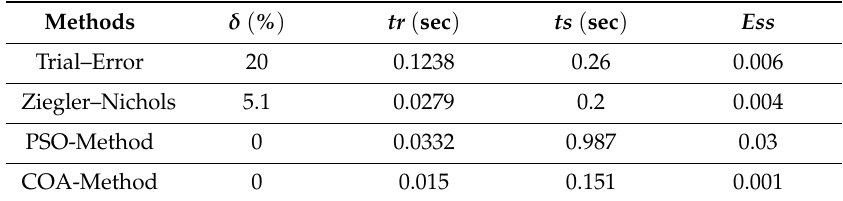
Table 2. Output performance under di ff erent